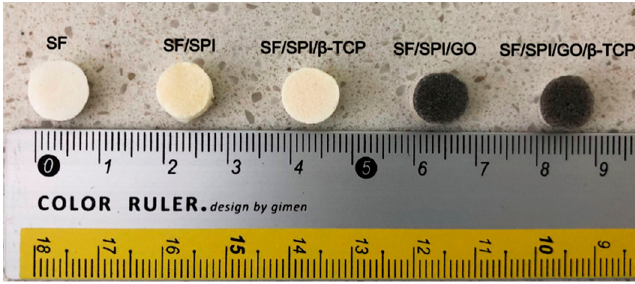
Figure 1. General observation of the SF/SPI-based composite scaffolds.